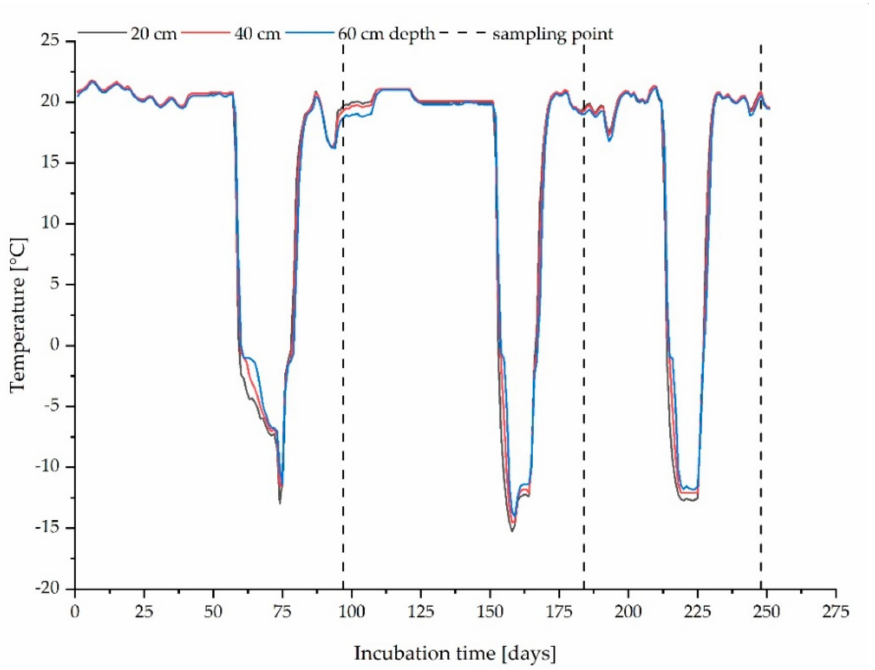
Figure 1. Temperature curve over the entire test period with three annual cycles, measured at 20, 40 and 60 cm distance from the edge of the reactor with treated soil ash/mixture. Dotted line marks the three sampling points after the winter phases (23 January, 24 April and 27 June).